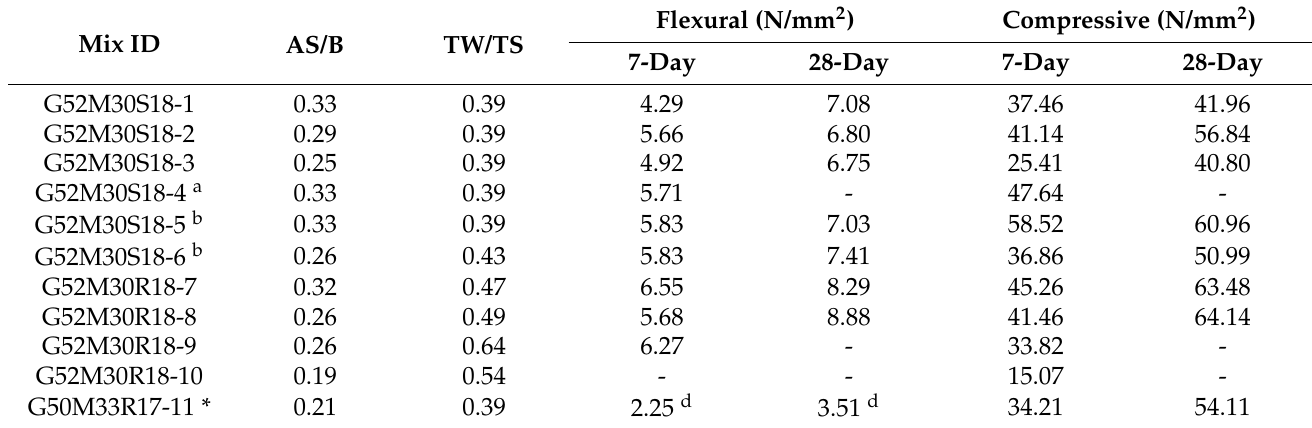
Table 3. Details of mix proportions and results for GGBS-based concretes.